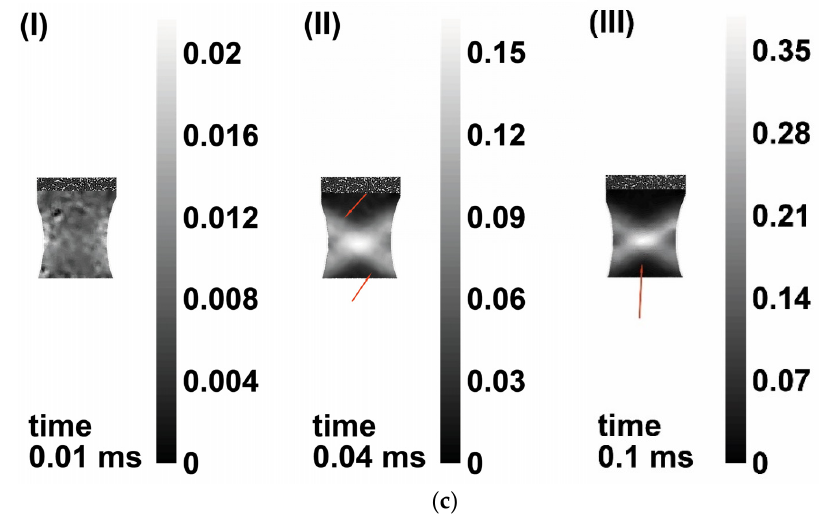
Figure 6. Fields of equivalent strain of specimens with the notch radius of 10 mm at ( a ) 0.1 s − 1 , ( b ) 100 s − 1 , and ( c ) 1000 s − 1 .